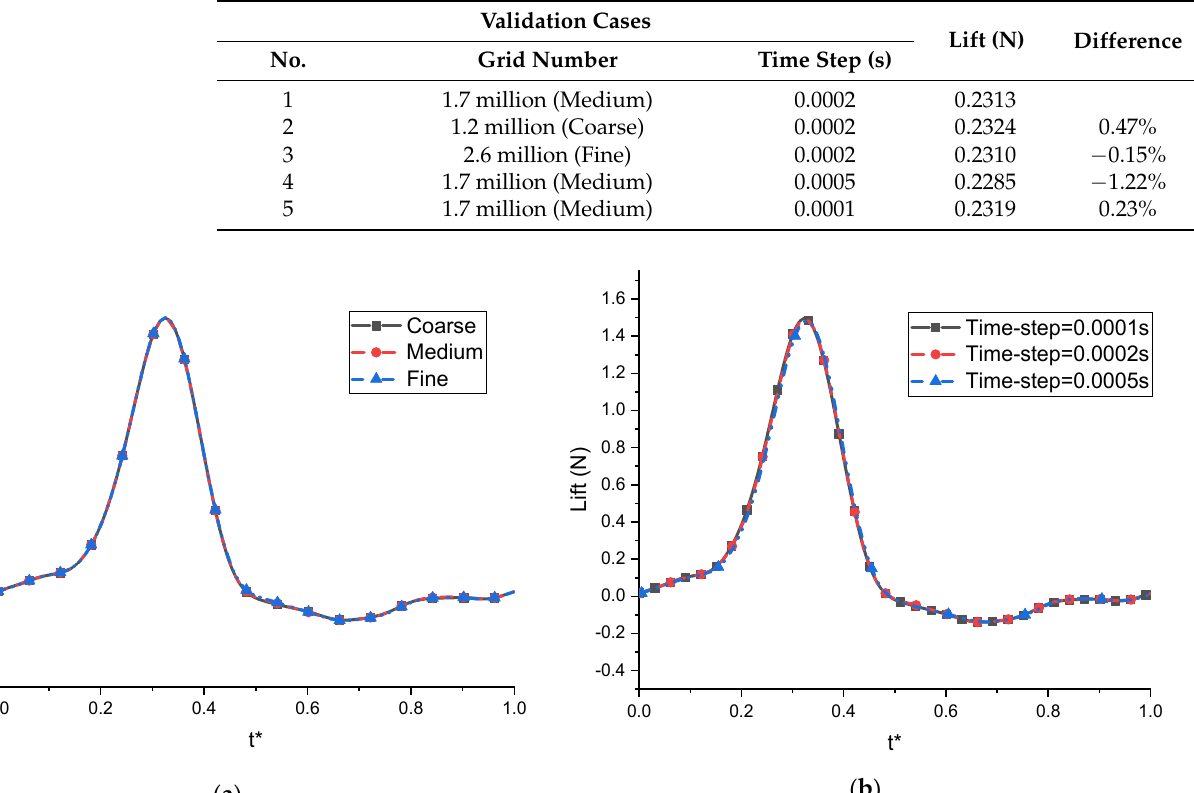
Table 2. Time-averaged lift results of the convergence studies.